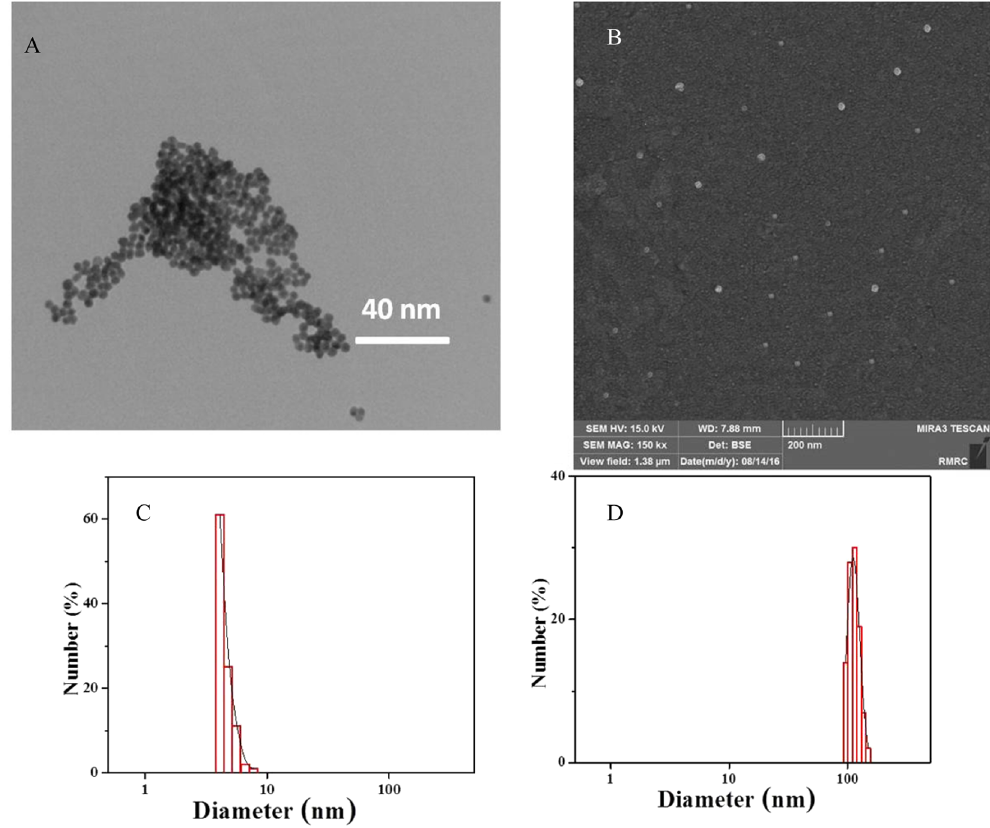
Figure 1. ( A ) TEM image, ( B ) SEM image, ( C ) DLS size distribution of SNPs, ( D ) DLS size distribution of